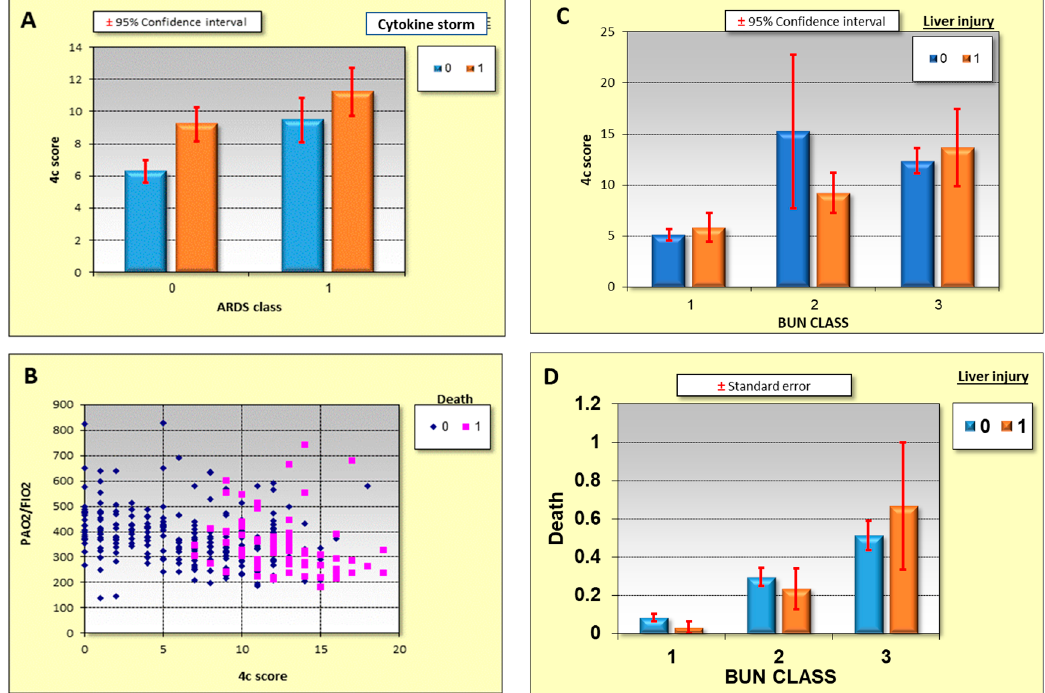
Figure 1. Correlations between ARDS, liver injury, PAO2/FiO2, the 4-C score, and mortality in COVID-19 patients. ( A ): Correlation between the 4-C score, cytokine storm syndrome and ARDS. ( B ): Correlation between the 4-C score, liver injury and BUN classes. ( C ): Correlation between the 4-C score and a decreased PAO2/FiO2 ratio and high mortality. ( D ): Correlation between liver injury, BUN class and high mortality. Standart deviation added to figures A,C and D.